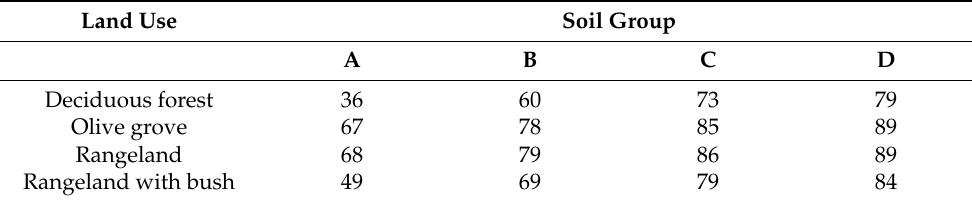
Table 2. CN per land use and soil group.